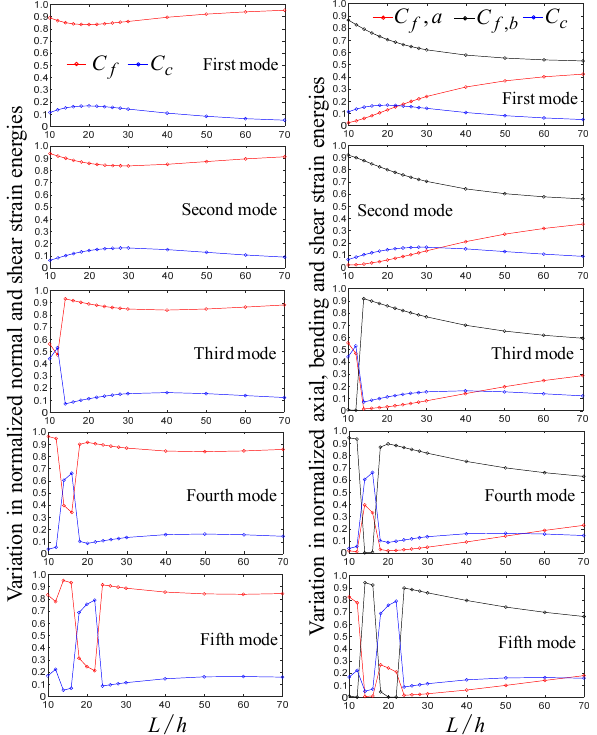
Figure 6. Variation in the strain energies on the natural frequencies of three ‐ layered beams with the C ‐ C end condition.